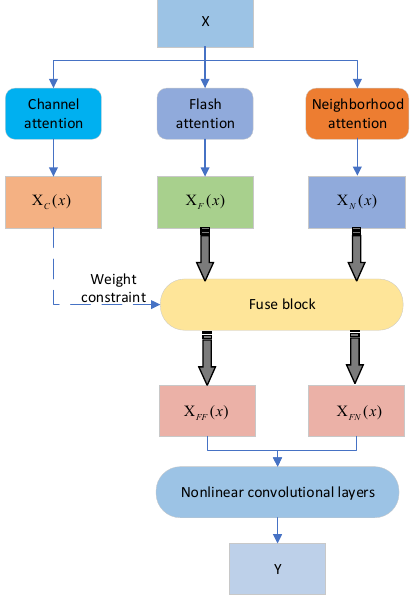
Figure 4. Schematic diagram of the fuse block.